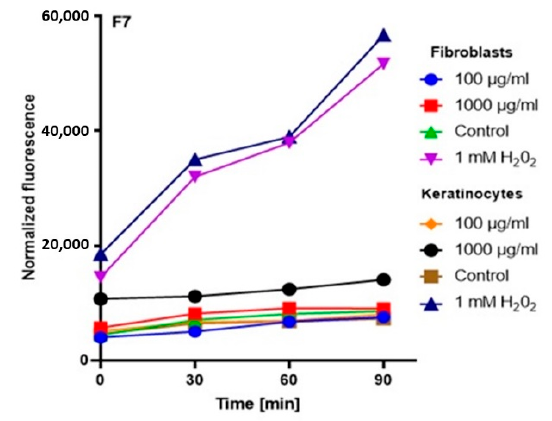
Figure 4. The effect of kombucha ferments’ extracts (F7) on the DCF fluorescence in fibroblasts and HaCaT cells. The data are expressed as the mean ± SD of 3 independent experiments, each of which consisted of 3 replicates per treatment group.